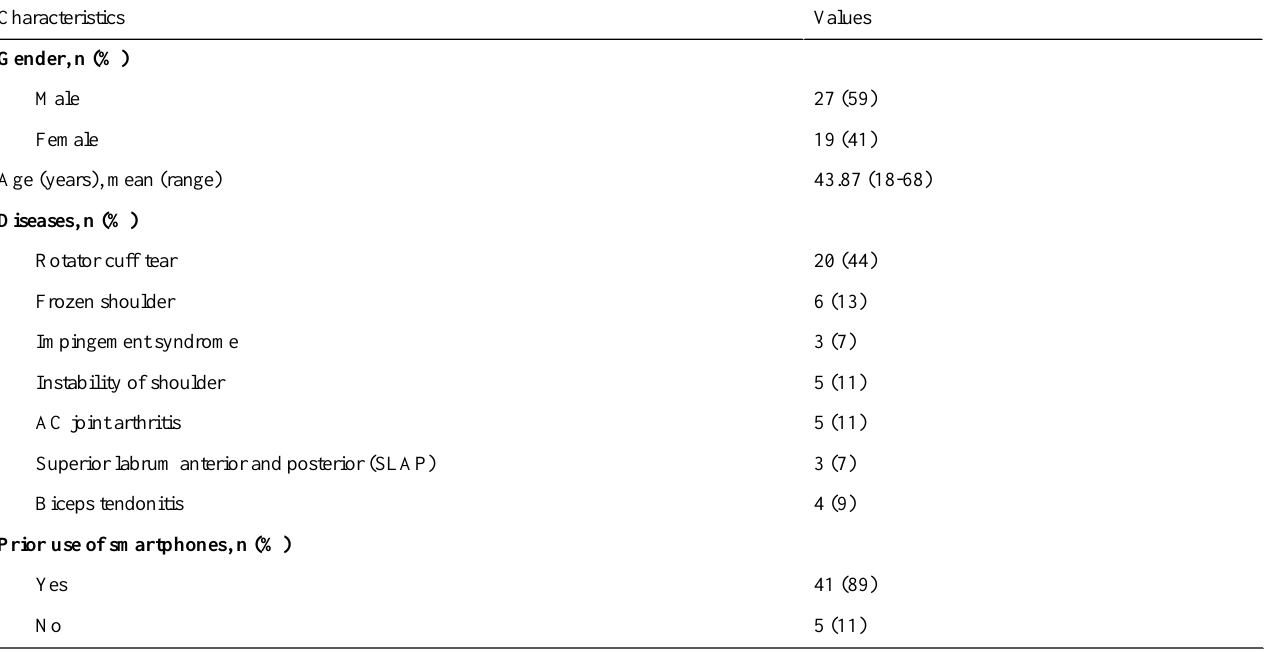
Table 2. Details of patients included in the study.